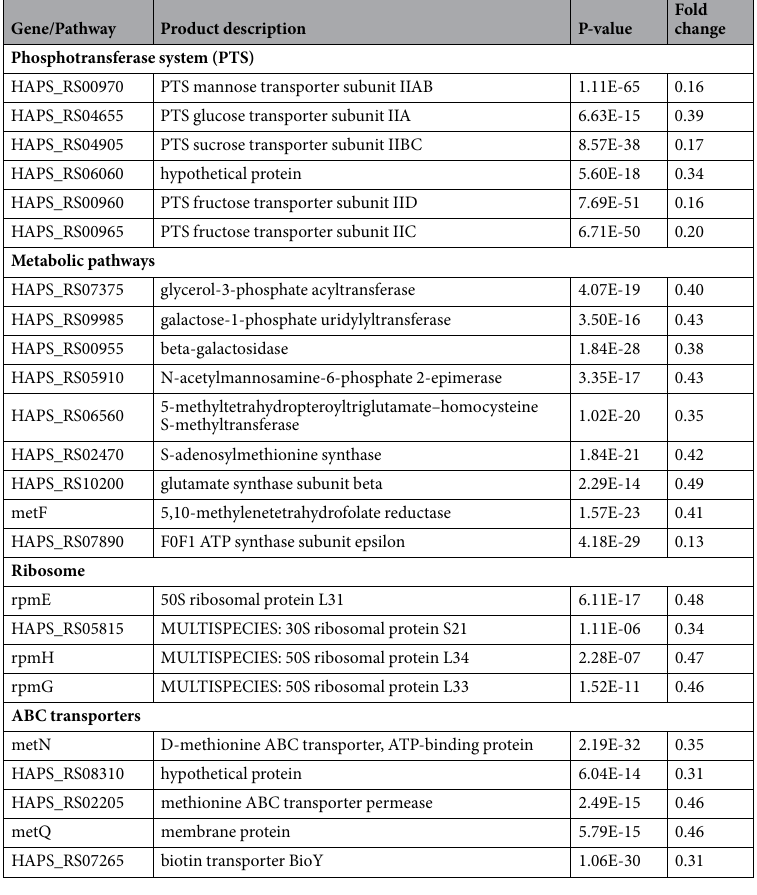
Table 4. The important down regulation genes of JS32 compared to JS0135 grouped by GO and KEGG pathways of interest. Note: Inf, represented